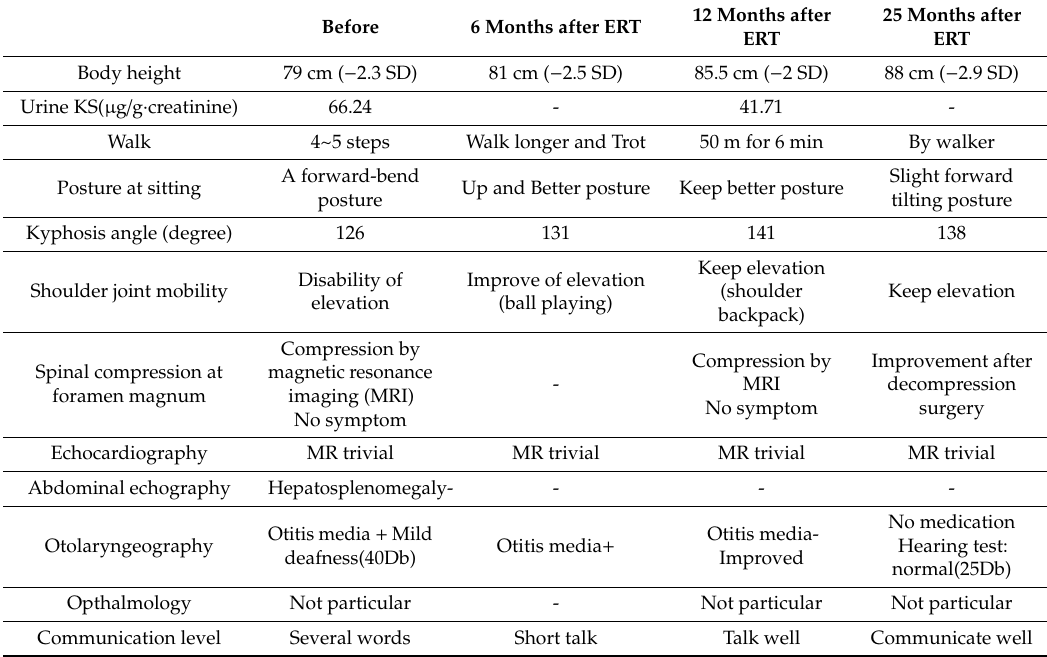
Table 2. The clinical course of a Japanese boy with MPS